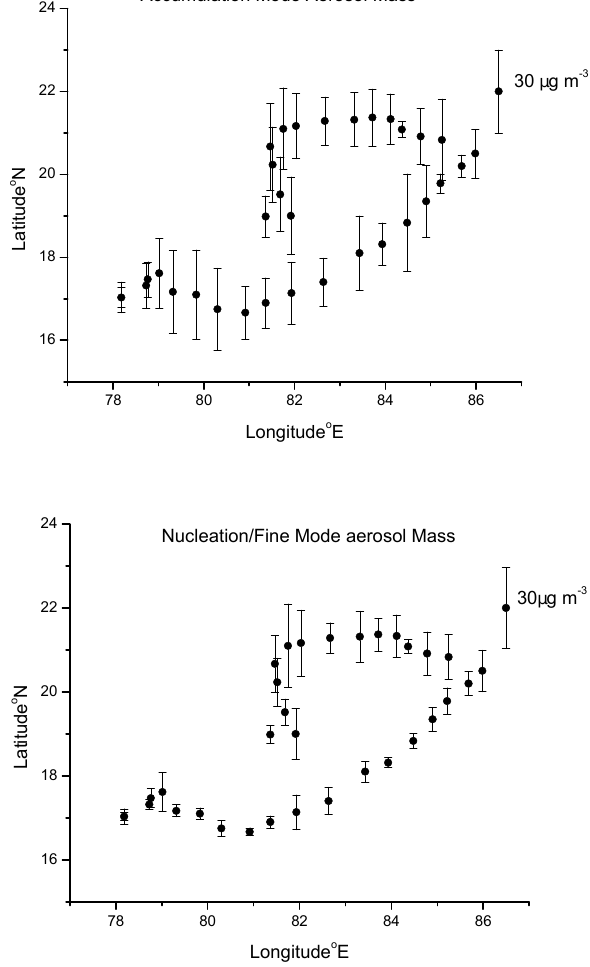
Fig. 6 Fig. 6. Accumulation (top panel) and nucleation (bottom panel)